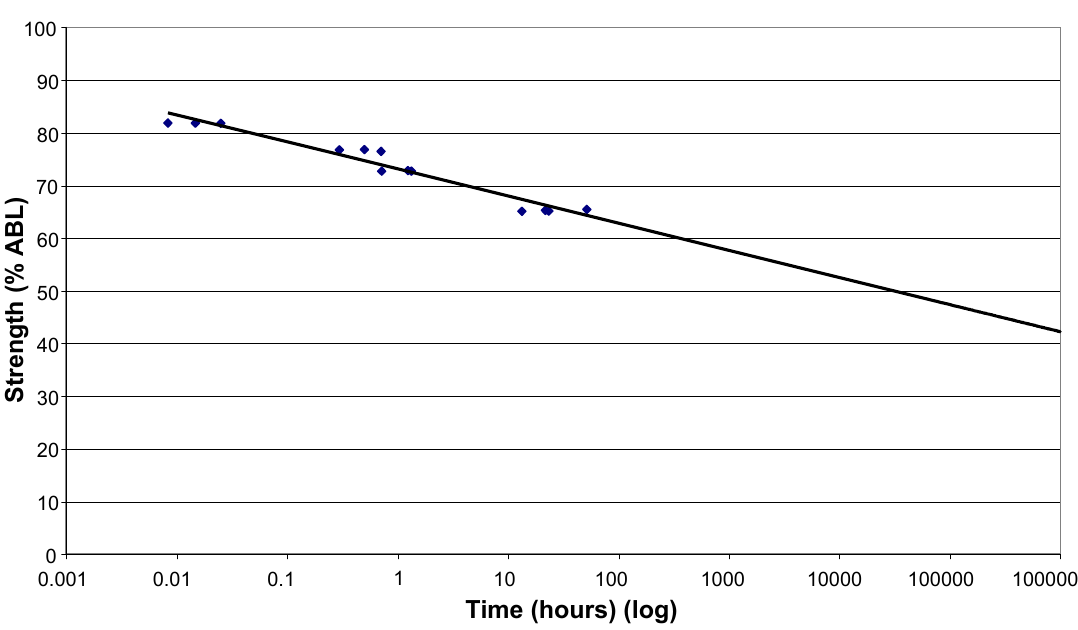
Figure 8. Creep rupture test